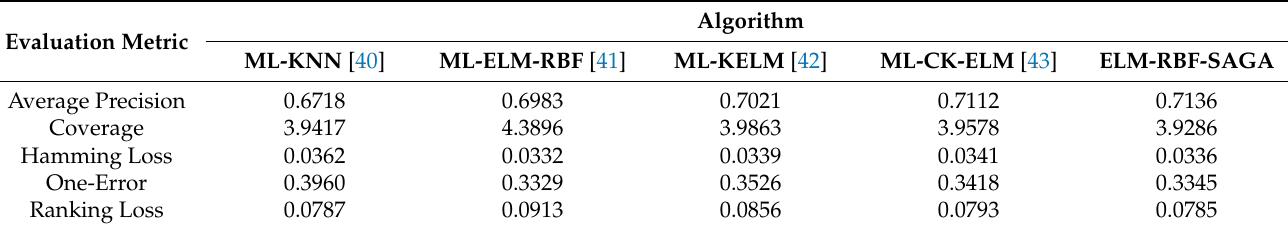
Table 8. Performance of different models in the computer dataset.